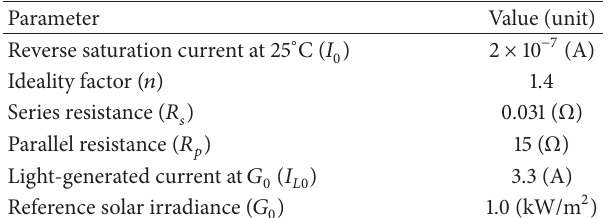
Table 2: Parameters of the solar cells used in SM50 PV module at